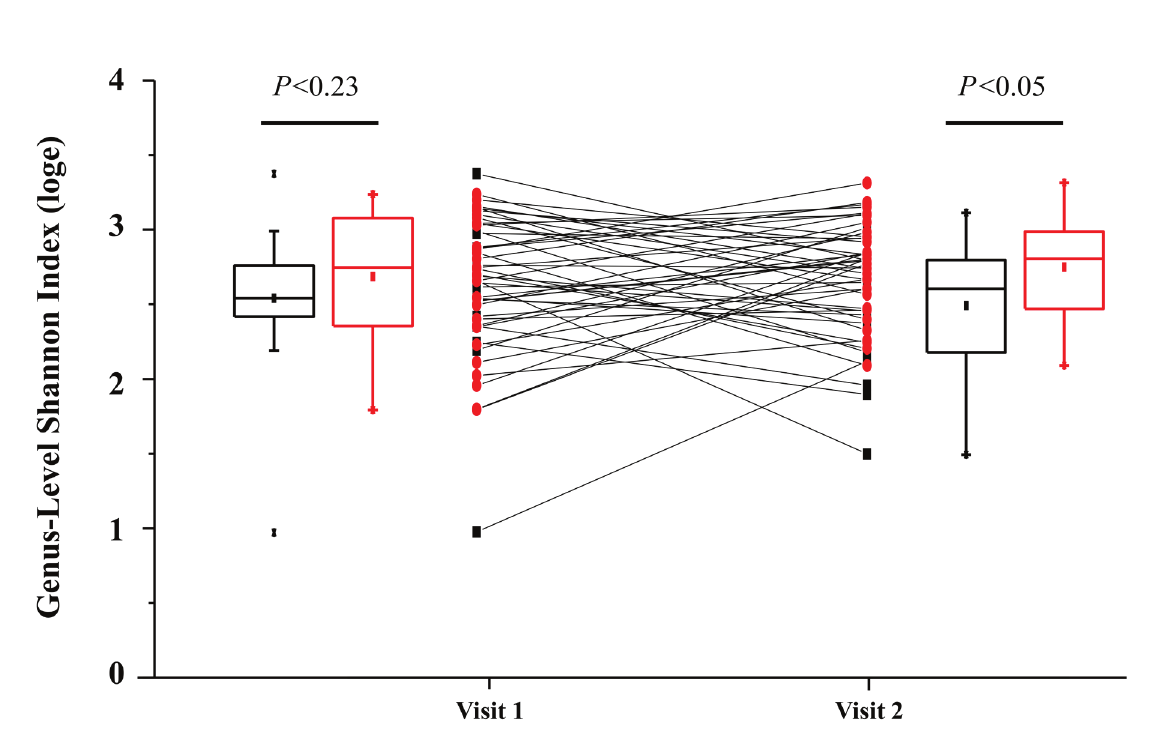
Figure 1B. Change in fecal microbial diversity between visit 1 (before treatment) and visit 2 (after treat- ment) for individuals taking rifaximin (red circles) and for individuals taking no study treatment (black squares). No significant difference in Shannon Index between treatment groups was observed at baseline (visit 1; Mann-Whitney U-test), but a significant difference was observed at visit